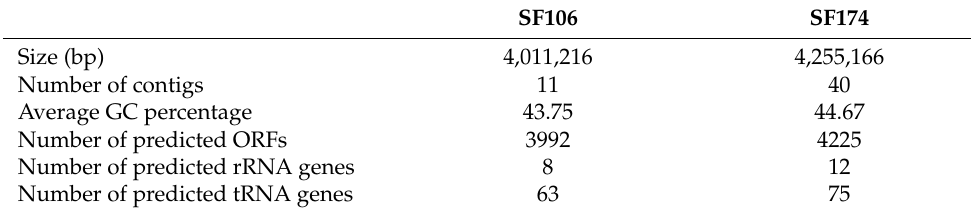
Table 1. General features of the SF106 and SF174